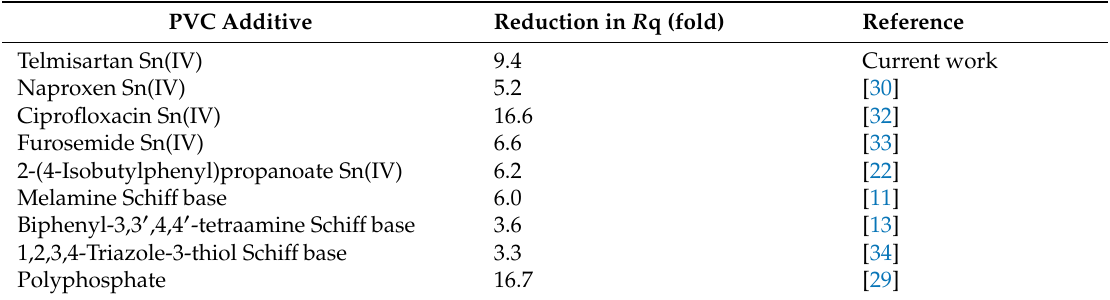
Table 1. Reduction in PVC roughness factor ( R q; fold) in the presence of di ff erent additives.